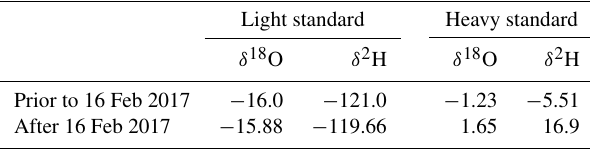
Table 2. Laboratory standard isotopic compositions. Light